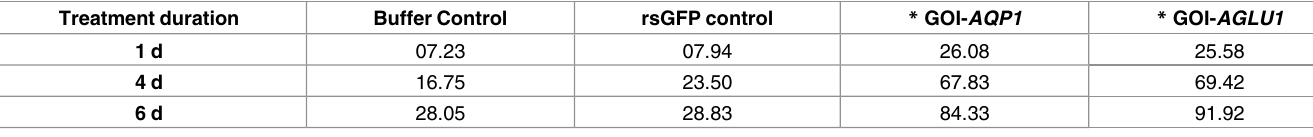
Table 5. Percent mortality post- AQP1 and AGLU1 dsRNA knockdown. Treatment